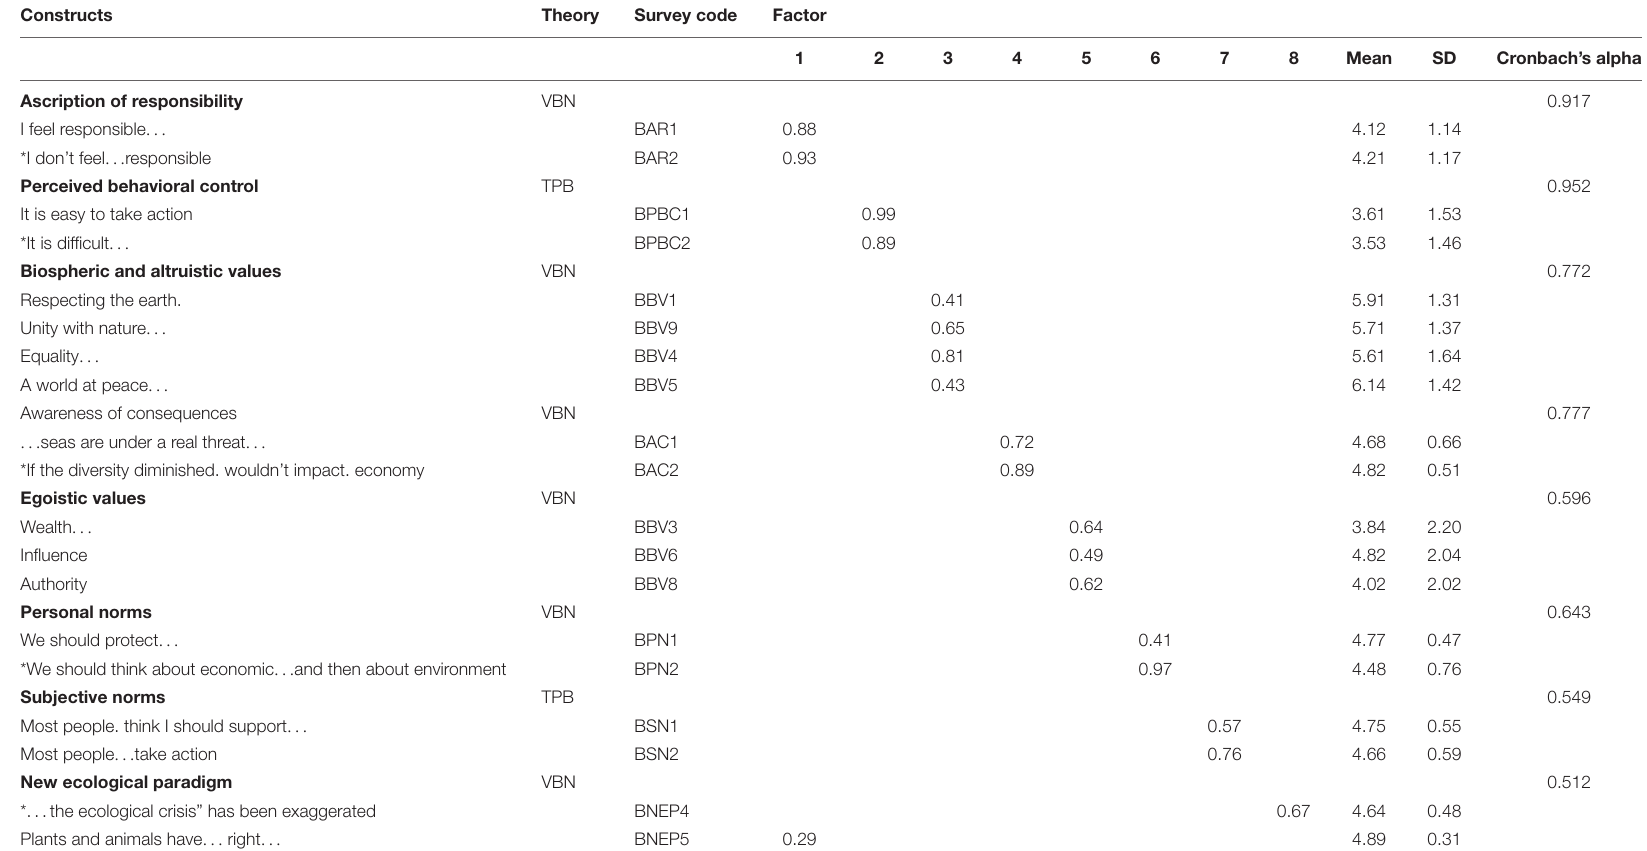
TABLE 1 | Factor analysis on values, beliefs, and norms regarding restoration of high-trophic level species and sustainable fisheries in the Gulf of Nicoya and reliability estimates for each extracted factor (pre-survey sample).